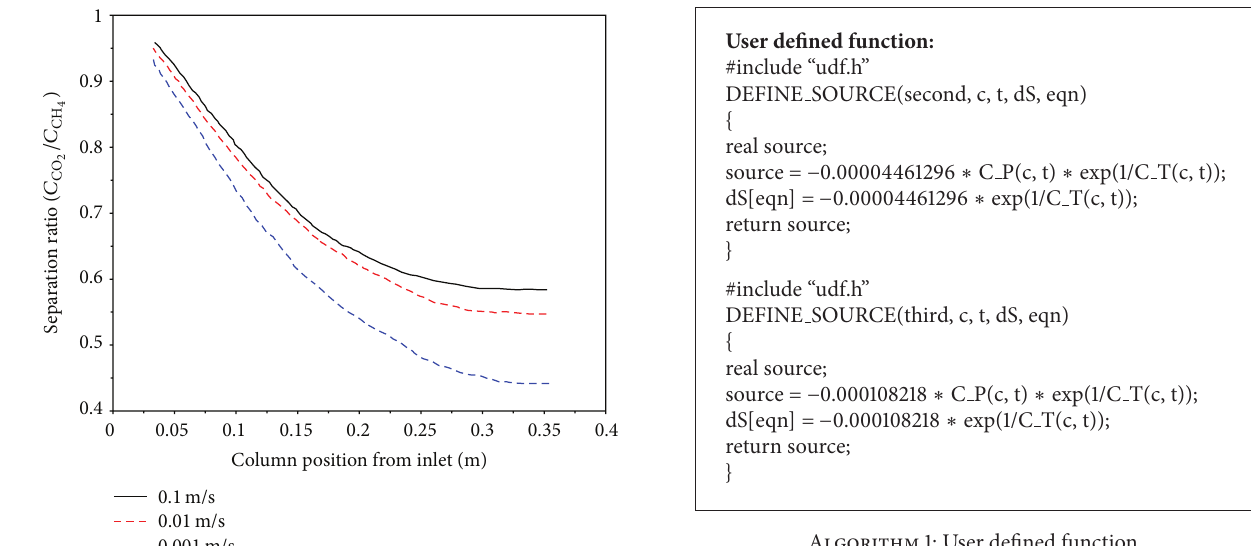
Algorithm 1: User defined